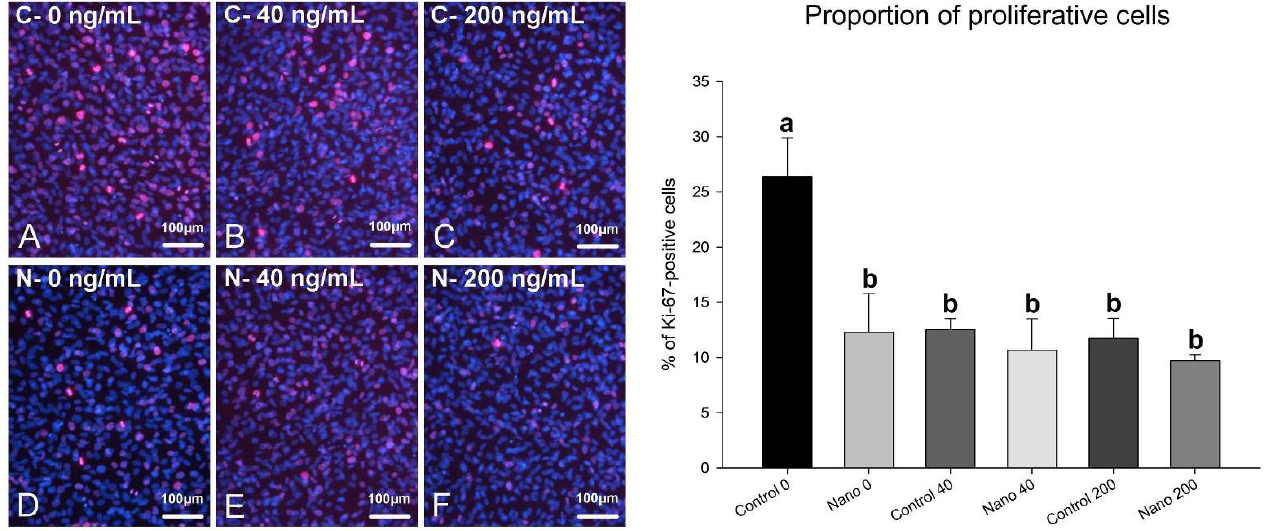
Figure 2. Epifluorescence imaging of Ki-67 labeling (left panel) and proportion of proliferative MC3T3-E1 cells (right panel) on day 5 of culture on Control-Ti ( A – C ) and Nano-Ti ( D – F ) exposed or not on days 2 and 4 of culture to 40 and 200 ng/mL BMP-7 in the culture medium. ( A – F ) Proliferative cell nuclei have red fluorescence (Ki-67+), and all cell nuclei are labeled with DAPI (blue fluorescence). Bars with different letters are significantly different from each other ( p < 0.05).